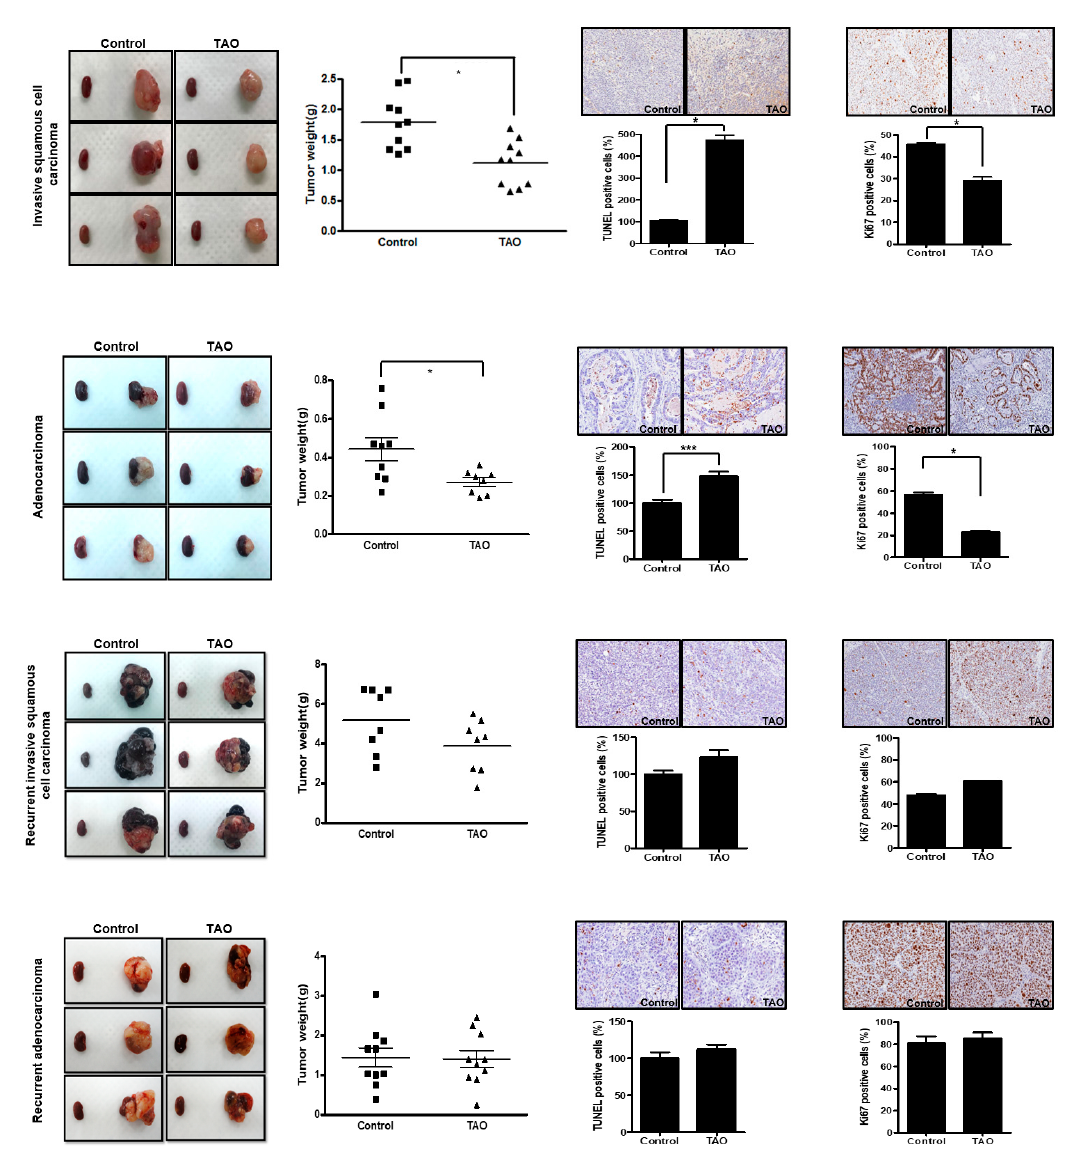
Figure 5. Gross appearance of xenograft from mouse models with primary invasive squamous cell carcinoma, adenocarcinoma, recurrent invasive squamous cell carcinoma, and recurrent adenocarcinoma of the cervix. The tumors of the control group ( left ) vs. the TAO-treated (8 mg/kg) experimental group ( right ) are shown, demonstrating statistically significant differences of tumor weight between the two groups in the primary cancer models. However, this difference is not seen in recurrent cancer models. The TUNEL assay and Ki-67 assay also show the anti-cancer effects of TAO in primary cancer models, while these effects are not seen in recurrent cancer models. * p -value < 0.05, *** p -value <